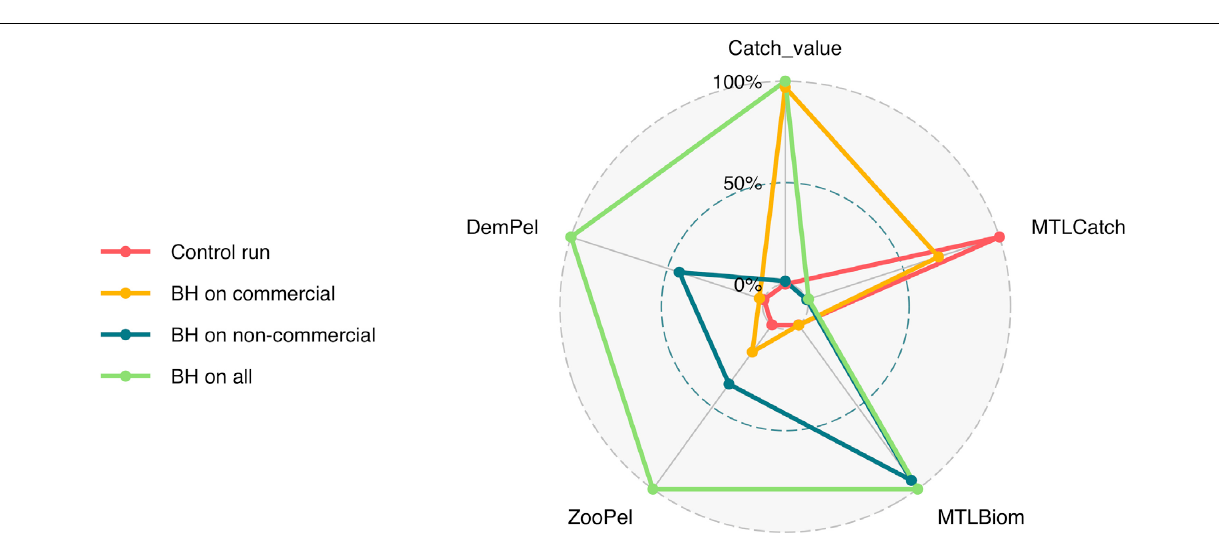
FIGURE 10 | Five indicators are represented in this figure including (i) the mean trophic level of the catch (MTLCatch); (ii) the mean trophic level of the biomass (MTLBiom); (iii) the relationship between zooplankton and pelagic fish (ZooPel); (iv) the relationship between pelagic fish and demersal fish (DemPel); and (v) the value of the commercial catch only, by the three combined scenarios as well as the control